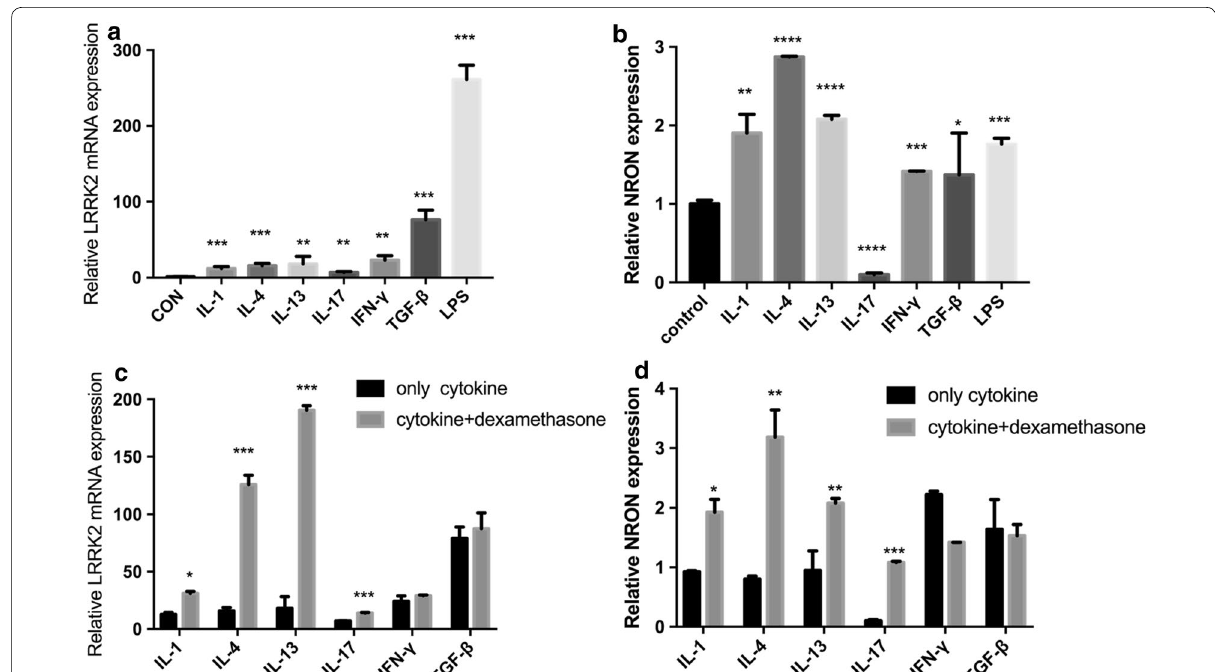
Fig. 4 LRRK2 mRNA and NRON expression in cultured HNECs in response to pro-inflammatory cytokines, LPS and dexamethasone. a LRRK2 mRNA, b NORN expression after a 12 h stimulation; c LRRK2 mRNA, d NORN expression after pro-inflammatory cytokines stimulation with or without dexamethasone. Results represent mean values from 3 independent experiments. Data are expressed as means (SEMs). * p < 0.05, ** p < 0.01, *** p < 0.001, **** p <